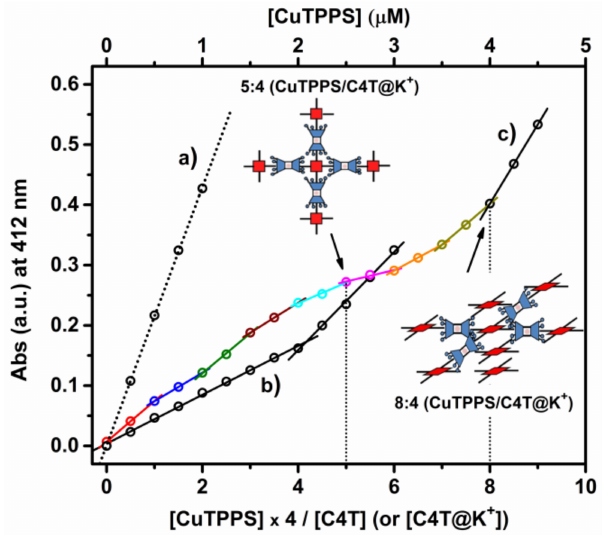
Figure 2. Variation in the absorbance of the CuTPPS Soret band ( λ max = 412 nm) observed upon: (i) increase of the porphyrin concentration in water (dotted black trace labelled as ( a )); (ii) portion-wise addition of CuTPPS to a 2 µ M aqueous solution of calix[4]tube C4T at pH = 3.0 (solid black trace labelled as ( b )); (iii) portion-wise addition of CuTPPS to a 2 µ M aqueous solution of C4T@K + at pH = 3.0 (multicolored trace labelled as ( c